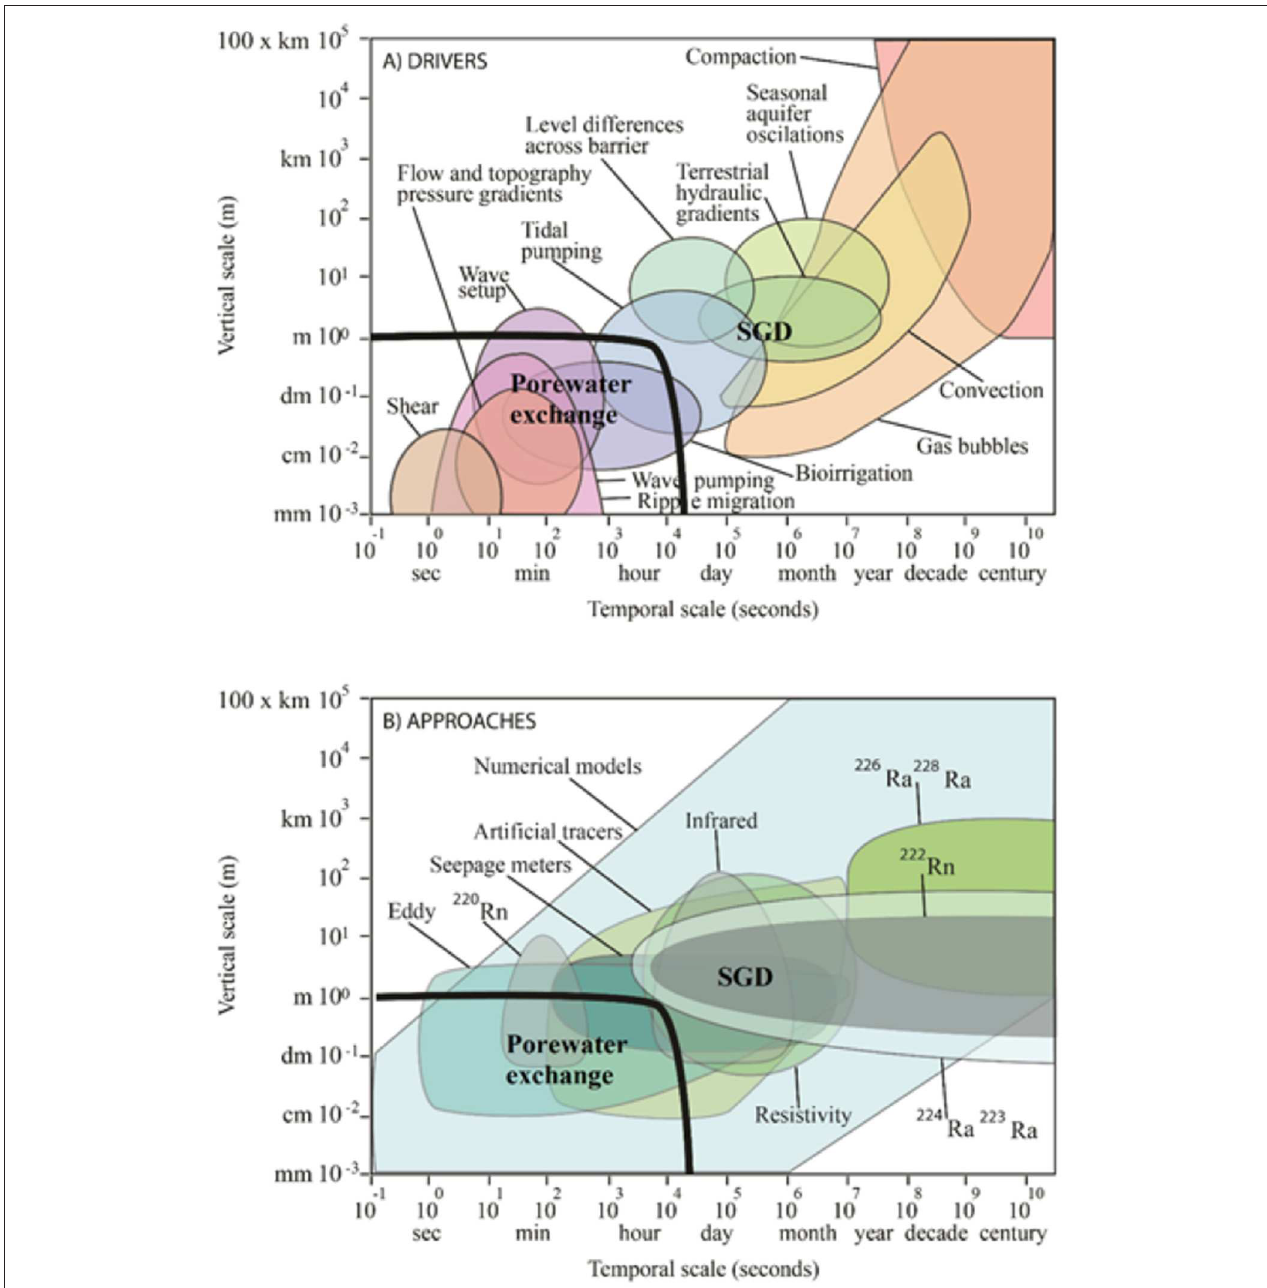
FIGURE 3 | (A) The operating space of the physical processes driving porewater exchange and SGD in coastal systems. The thick black line separates the porewater exchange space (bottom left) from the SGD space according to Moore (2010)’s definition. (B) The approaches used to quantify SGD (bottom graph) often capture multiple drivers, preventing a straightforward quantification of individual physical